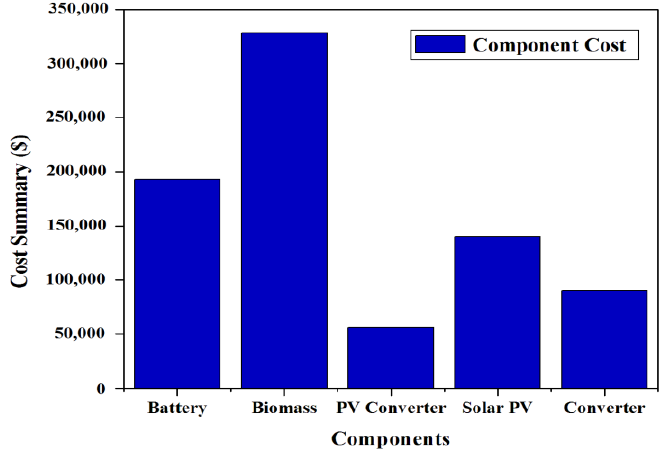
Figure 17. Total component cost breakdown for case II (Ba/Bi/S).